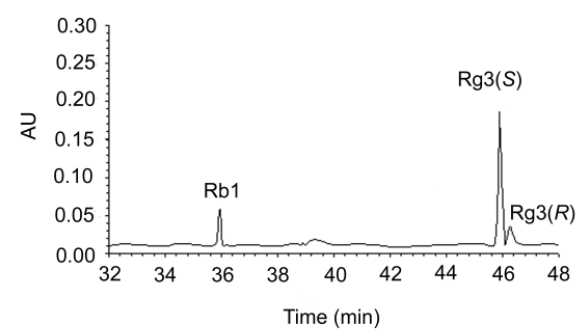
Figure 3: HPLC profile of the metabolites of ginsenoside Rb1 under PEF treatment (electric field intensity 20 kVcm -1 , pulse number 10 and acid concentration 0.2mol/L). The mixed reaction was extracted by n-BuOH, evaporated vacuo and analyzed by HPLC after dissolved in MeOH.